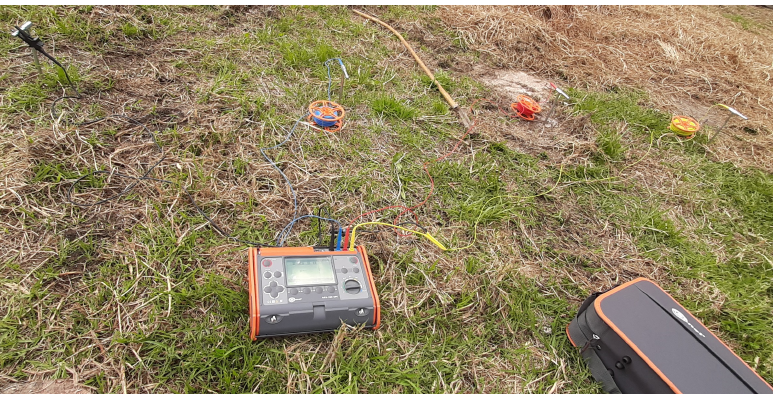
Figure 5. Measurement of the soil resistivity 1 (S1).